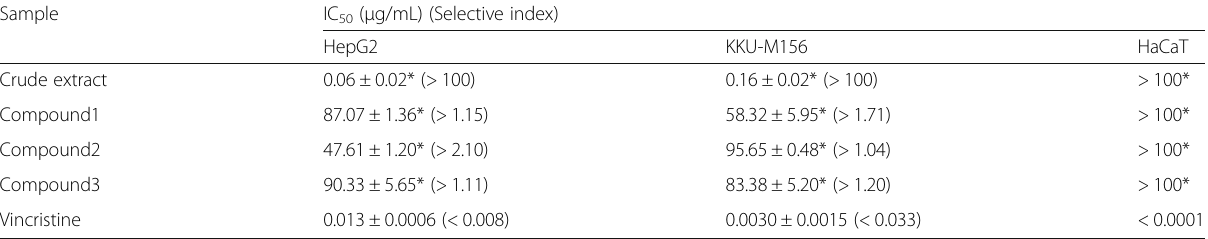
Table 3 Cytotoxic activity of the crude ethanolic extract and the isolated compounds against cancerous liver cells (HepG2 and KKU- M156) and normal cells (HaCaT)